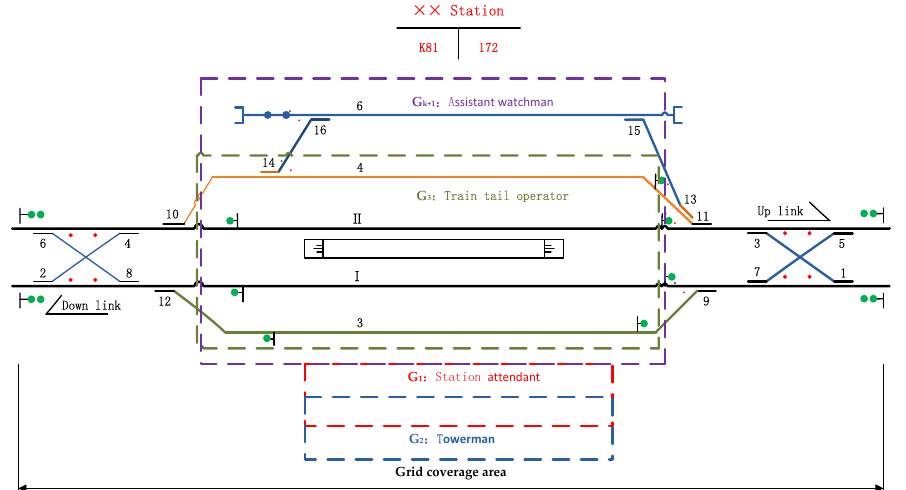
Figure 1. Railway station grid division. Figure 2. Railway station grid